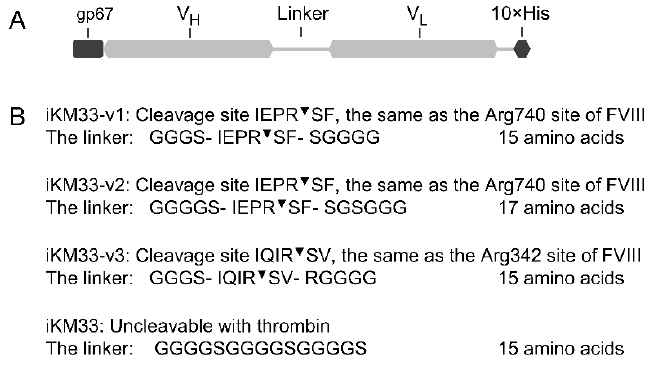
Figure 1. Design of iKM33 variants cleavable by thrombin. ( A ) Structural diagram of the constructs, which include a signal peptide gp67, V H and V L domains connected by a linker with thrombin cleavage site, and 10 × His tag for purification. The signal peptide is cleaved off during protein secretion upon expression in Sf9 cells. ( B ) Amino acid sequences of the linkers in three cleavable scFv variants and parental (uncleavable) iKM33 [34]. The cleavage positions are indicated ( ▼ ).